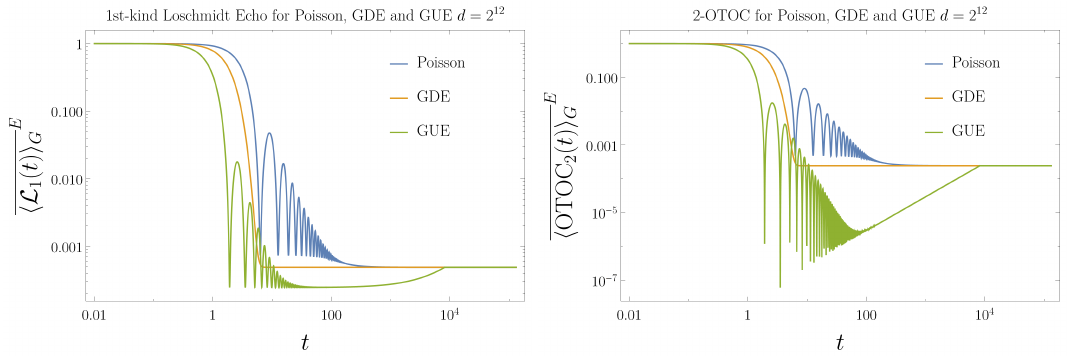
Figure 5: Left : Log Log plot for the Loschmidt-Echo of the first kind (see Eq. (36)) for Poisson, GDE and GUE ensemble and d = 2 12 . Poisson and GDE being always greater (cid:112) than the asymptotic value 2 / d they reach it in a time O ( d 1 / 2 ) and O ( log d ) , while GUE stays at the value 1 / d for the whole temporal interval t ∈ [ O ( d 1 / 3 , O ( d )] and then reaches the asymptotic value. Right : Log Log plot of the 2-OTOC see Eq. (43) for Poisson, GUE, GDE ensembles and d = 2 12 when A is a Pauli operator. The behavior of the 2-OTOC is completely dictated by ˜ c : Poisson and GDE reaches the asymptotic 2 (cid:112) value 1 / d in a time O ( d 1 / 2 ) and O ( log d ) , while GUE in a time O ( d )